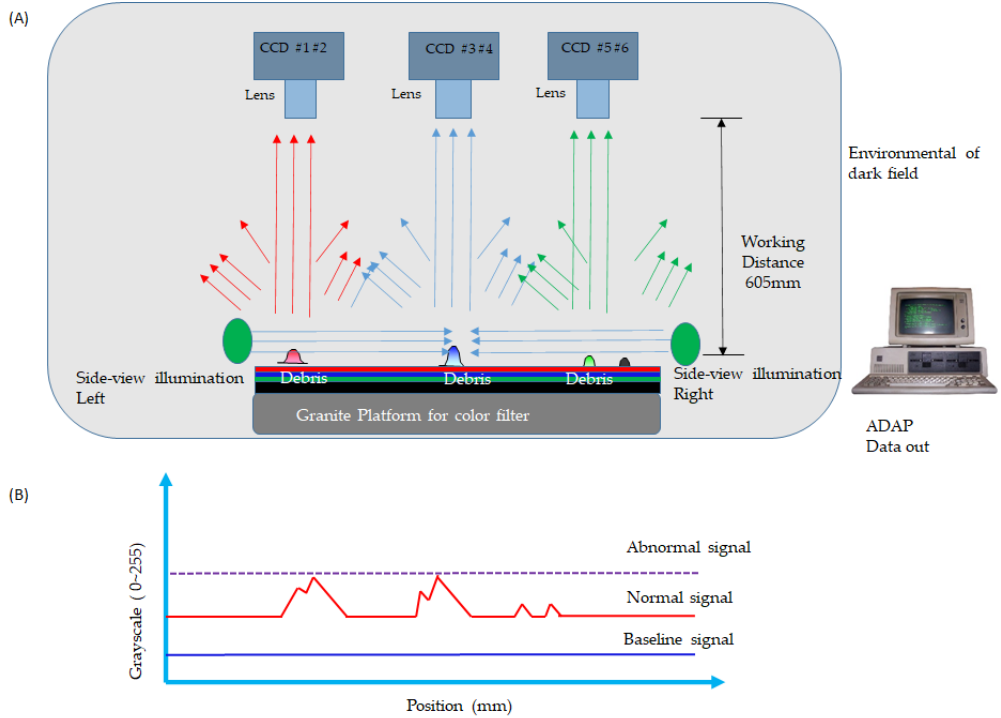
Figure 1. The struture of the photosensor that detects debris on the color filter (CF); ( A ) is a topology of the side-view illumination by the photosensor in the dark field, and ( B ) is the grayscale tendency.